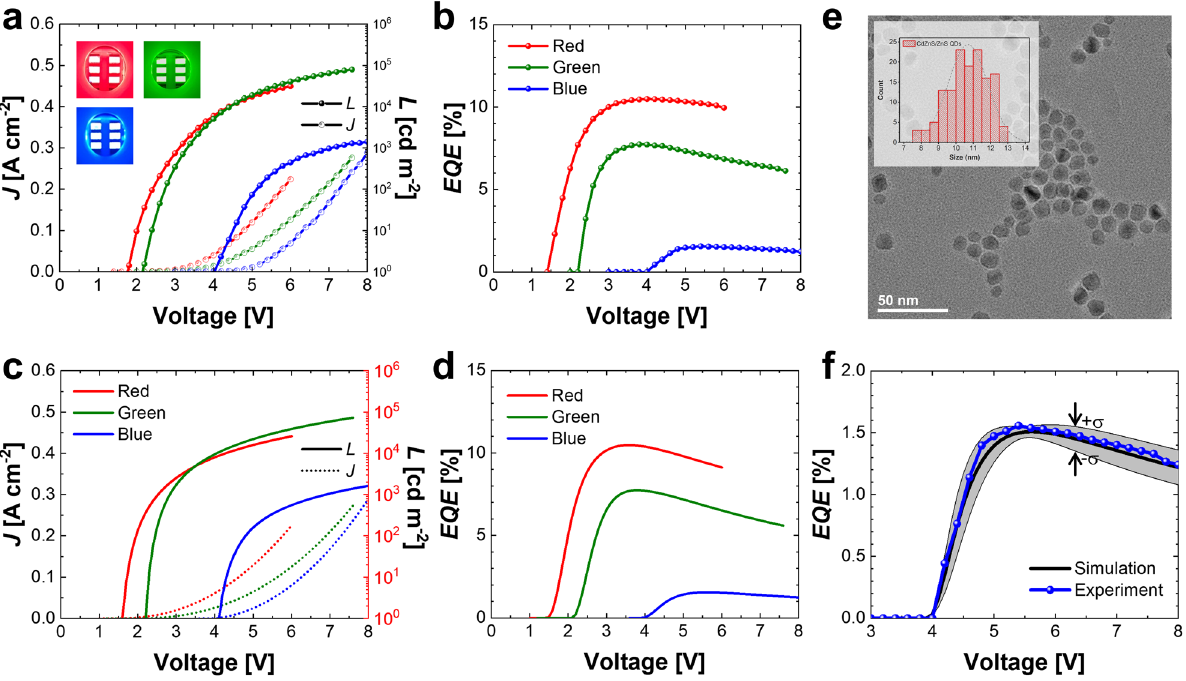
Fig. 5 Comparisons of the simulated and experimental electro-optical characteristics of red, green and blue QD-LED devices. Based on the same device architecture, red (628 nm), green (545 nm) and blue (465 nm) QDs having the optical bandgaps of 1.97, 2.28 and 2.67 eV are used for the simulation, respectively. a Luminance and current density curves and b EQE curves measured from the fabricated red, green and blue QD-LEDs. Insets are snapshots of the fabricated red, green and blue QD-LED devices. c Luminance and current density curves and d EQE curves of the red, green and blue QD-LED devices emulated by the charge transport simulation model. e TEM image of the blue QDs. Inset is the histogram of the blue QD particle size. f Variation of simulated EQE curves within the standard deviation ( σ ) range for the measured particle size distribution. Table 1. Parameters for the charge transport simulation to emulate the experimental curves of red, green and blue QD-LED devices fabricated in this